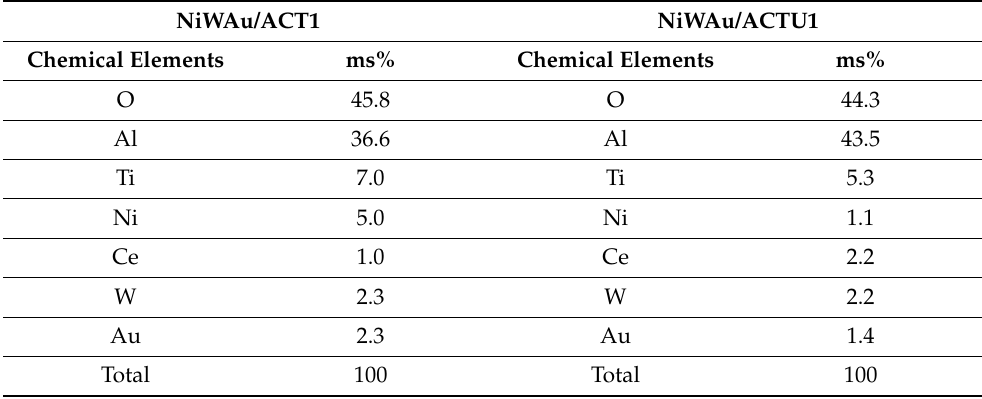
Table 4. EDX quantitative analysis of trimetallic nanomaterials NiWAu NPs supported on Al 2 O 3 - CeO 2 -TiO